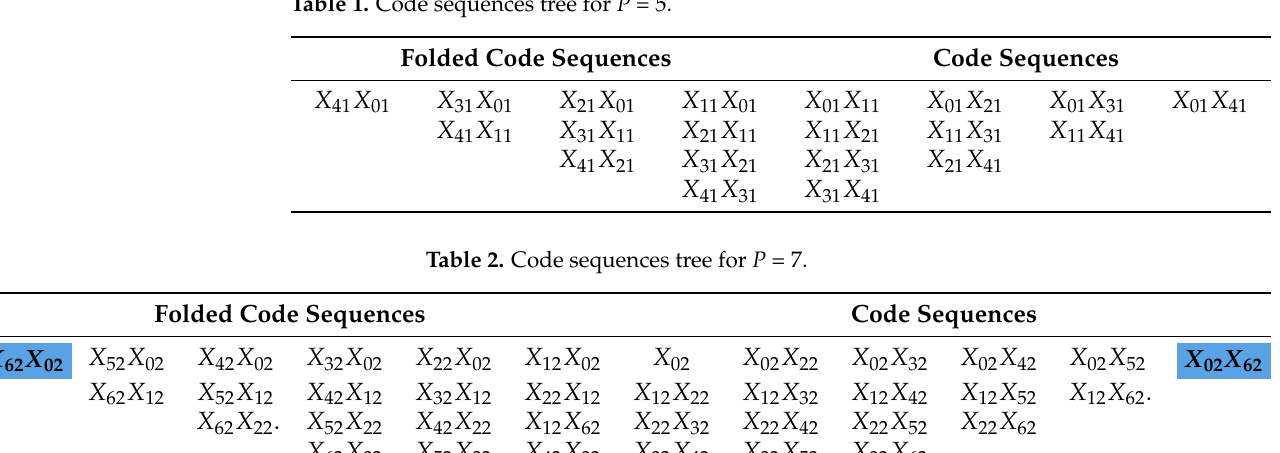
Table 1. Code sequences tree for P = 5.